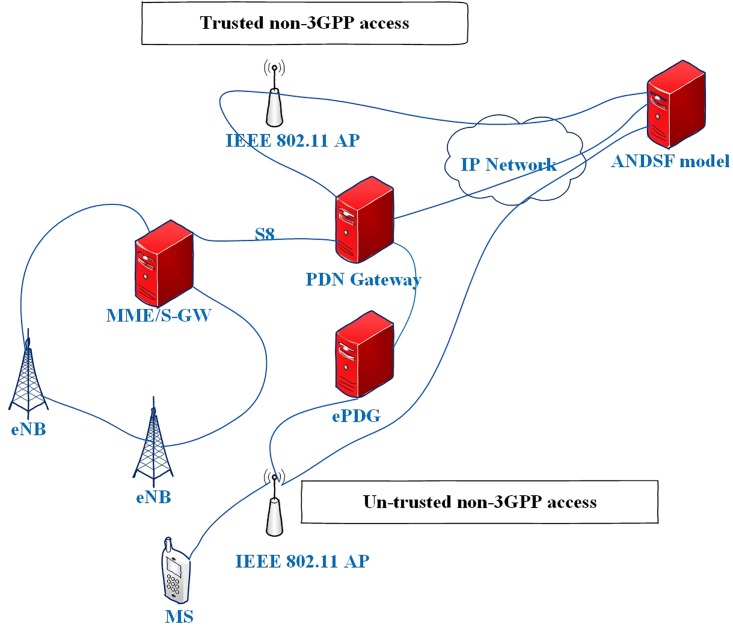
LTE-WLAN interconnection [41].